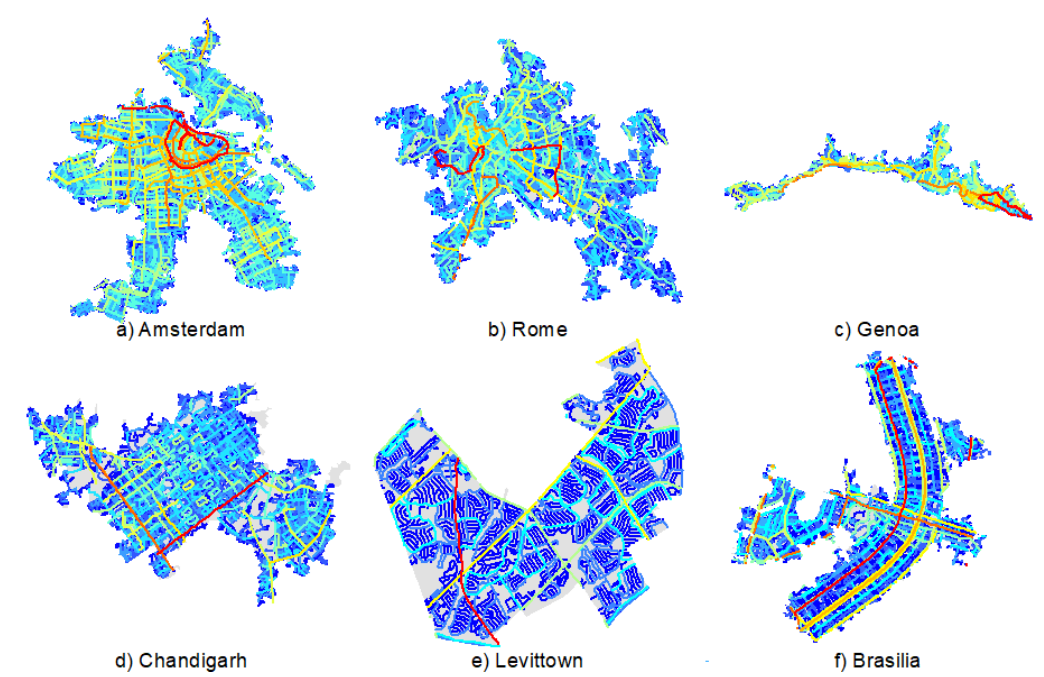
Figure 6. Natural street comparison between the artificial and historical cities. In warmer colors (red), the most well-connected natural streets are shown, with colder colors (blue) showing less connected streets. The top panels ( a – c ) show historical cities and the bottom panels ( d – f ) show artificial ones. The natural streets are classified according to head/tail breaks, and more details can be found in Table 2.